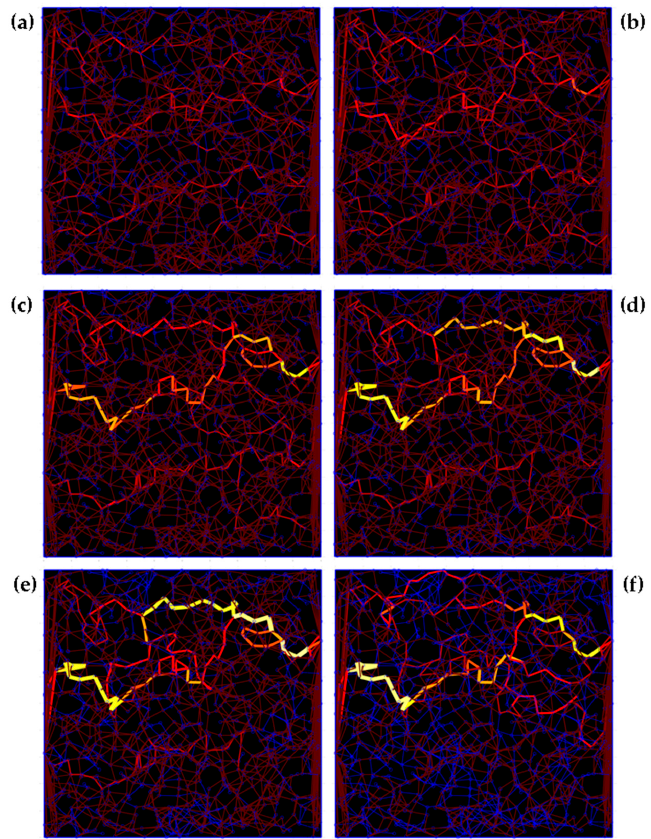
Figure 9. Changes in the current paths (from left to right) within the identical rectangular network by increasing the potential barrier: λ = [0.04 ( a ); 0.23 ( b ); 0.95 ( c ); 2.14 ( d ); 3.81 ( e ); 8.57 ( f )] eV.